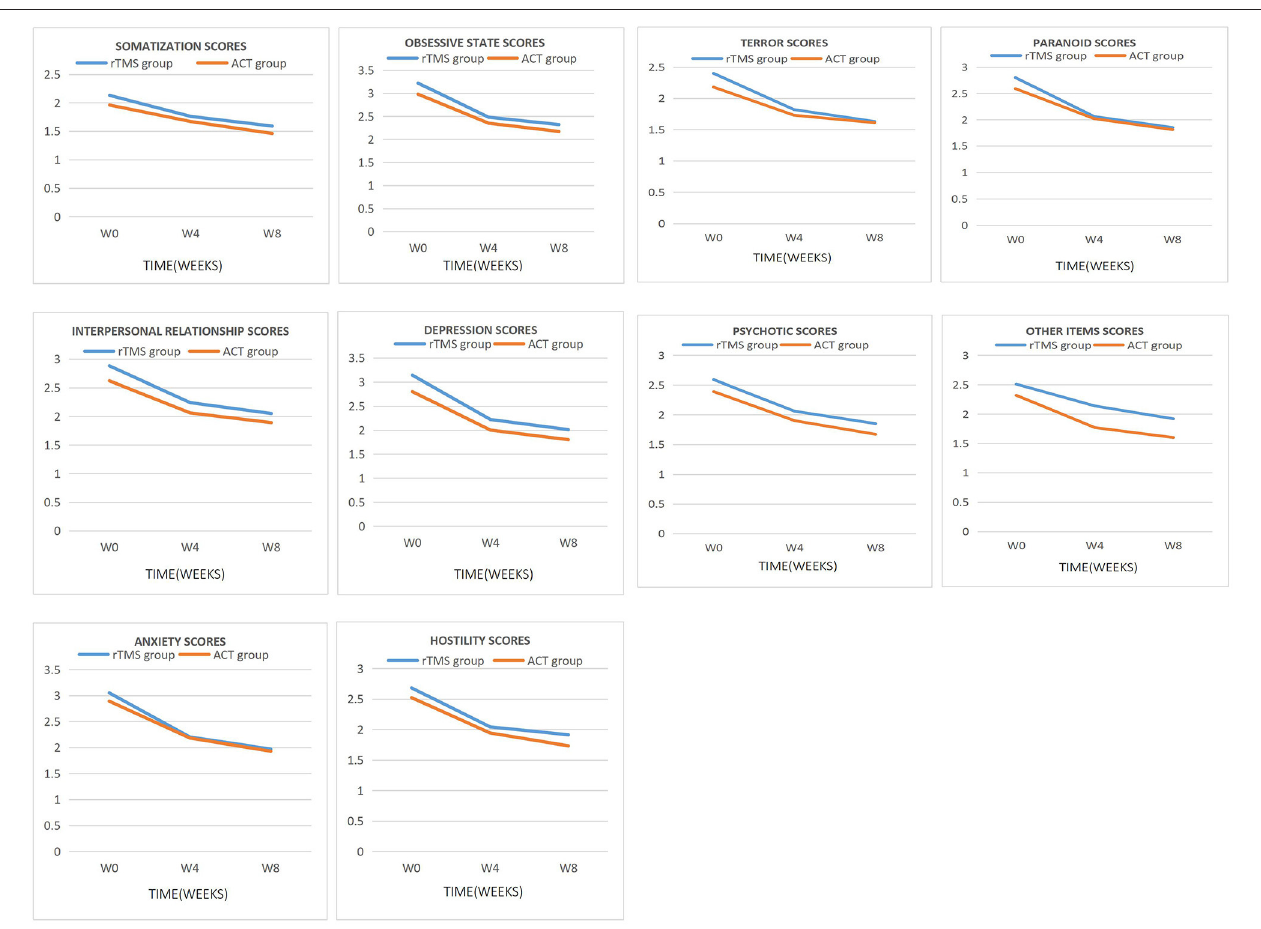
FIGURE 1 | Main effect of time was observed for each factor scores of SCL-90.